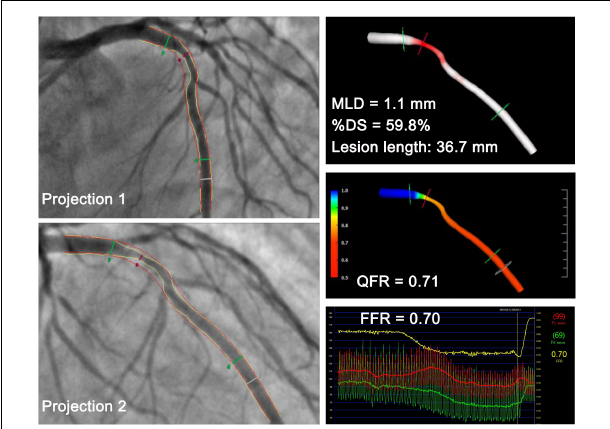
TABLE 1 | Baseline clinical